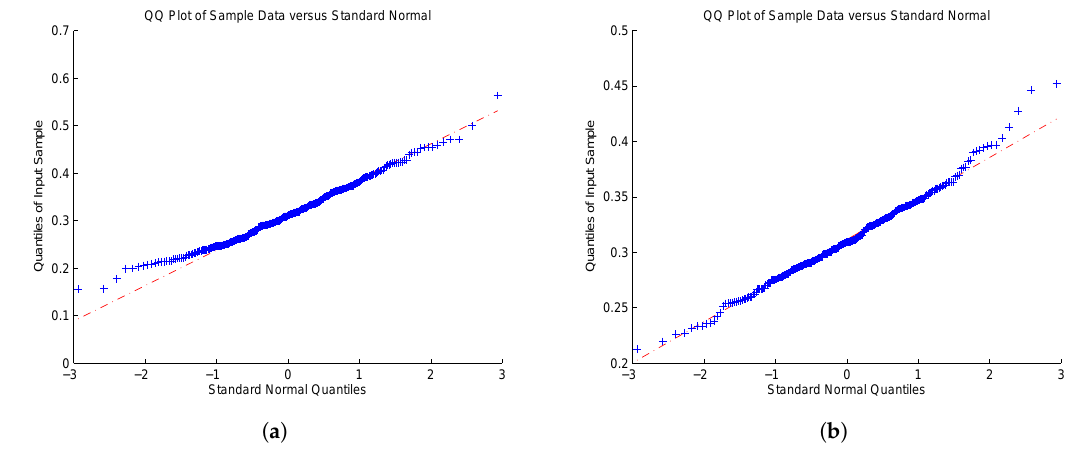
Figure 3. QQ-plot of (cid:98) φ K ( 5 ) for (CP); T n = 120 ( a ) and T n = 360 ( b ).